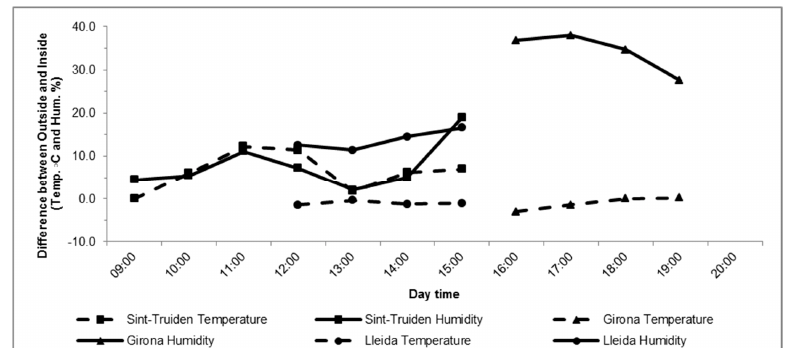
Figure 1. Difference in relative humidity and temperature between the outside and the inside of the plastic covered trees during the humidity increase period in Sint-Truiden, Belgium, in 2018 ( ▪ ), and Girona ( Δ ), and Lleida ( ● ), Spain, in 2019. The solid line represents the air relative humidity (%), and the dashed line represents temperature (°C).